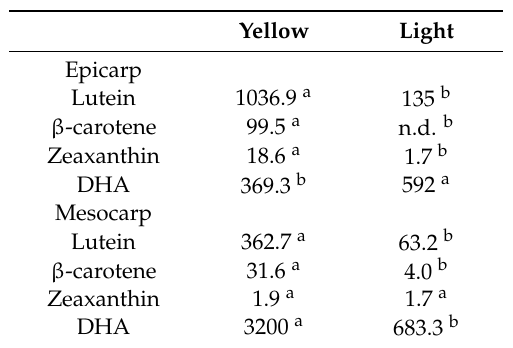
Means within the same row followed by the same letter are not significantly different using Student’s test at p < 0.05. n.d.: not